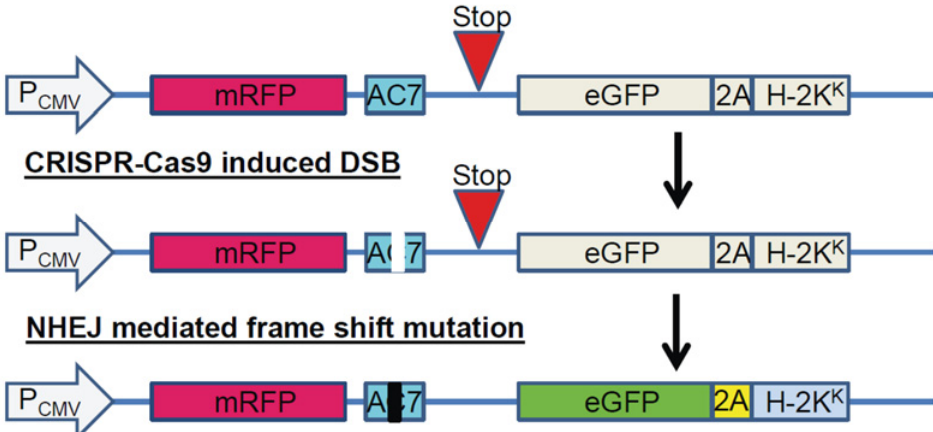
Figure 6. Surrogate Reporter. The figure shows how the reporter generates mRFP ‐ eGFP fusion protein because of a gene ‐ editing event. P CMV : cytomegalovirus promoter; mRFP: coding sequence of monomeric red fluorescent protein; AC7: AC7 gene derived target sequence; Stop: in ‐ frame stop codon; eGFP: coding sequence of enhanced green fluorescent protein; 2A: self ‐ cleaving peptide; H ‐ 2K K : mouse MHC class I alloantigen; DSB: double ‐ strand break; NHEJ: non ‐ homologous end ‐ joining.